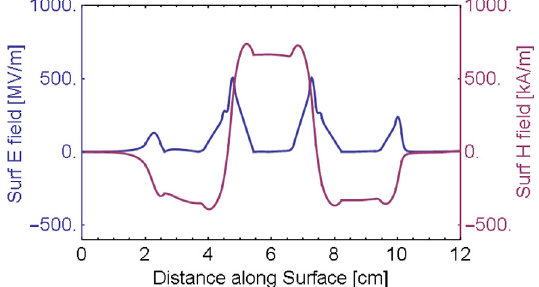
FIG. 2. Electric and magnetic fields along the surface for the X -band cryogenic cavity, scaled to 250 MV = m accelerating gradient in the middle cell.